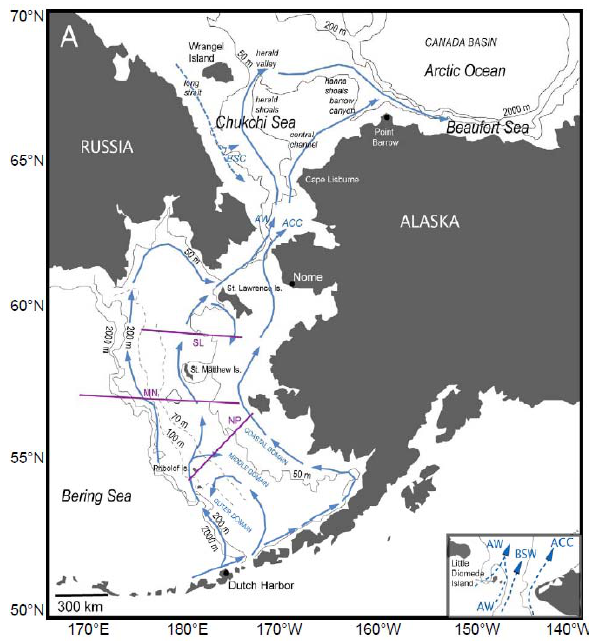
Fig. 1. Map of the Bering Sea showing the locations of the three domains, Outer Middle and Coastal. The locations of the three east- west transect lines (SL, MN, and NP) are also shown as well as the generalize circulation. During the winter, sea-ice covers much of the Bering Sea shelf, but the advance is constrained by the pres- ence of relatively warm water in the central and southern Bering Sea. During winter, water-masses are confined to a small range of temperature-salinity through mixing and homogenization by venti- lation, brine rejection and mixing. During the summertime, sea-ice retreats into the Chukchi Sea and Canada Basin of the Arctic Ocean.